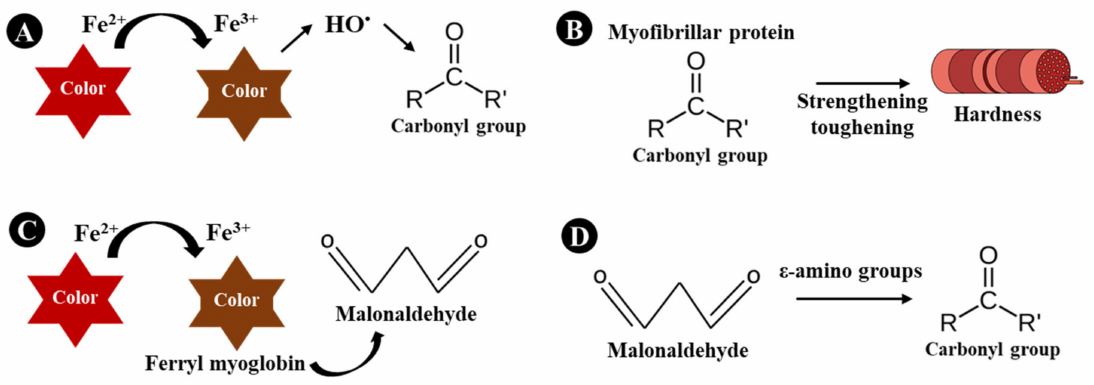
Figure 3. Plausible connections among physicochemical characteristics in Brazilian dry-cured loin. Connections between color and protein oxidation ( A ), texture profile and protein oxidation ( B ), color and lipid oxidation ( C ) and lipid and protein oxidation ( D